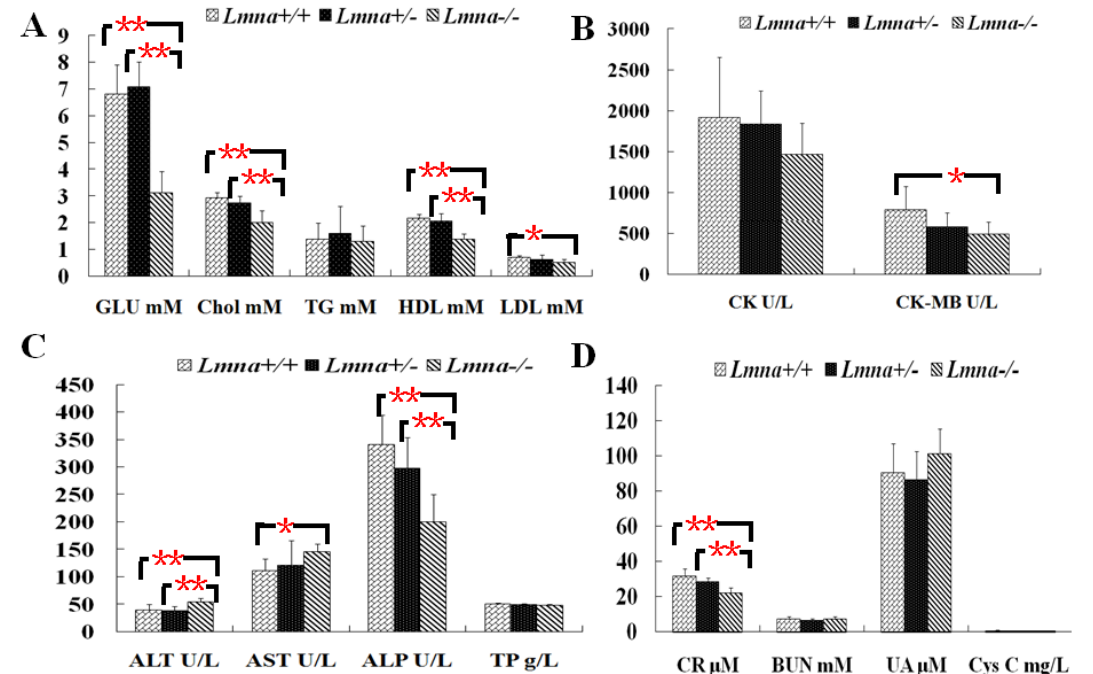
Figure 5. Blood biochemical values of Lmna +/+ , Lmna +/- and Lmna -/- mice. (A) Glycolipid metabolism correlation index; (B) Cardiac function indicators; (C) Liver function indices; (D) Renal function indices. The data are presented as the mean  SD, n = 30. * Indicates p<0.05; ** Indicates